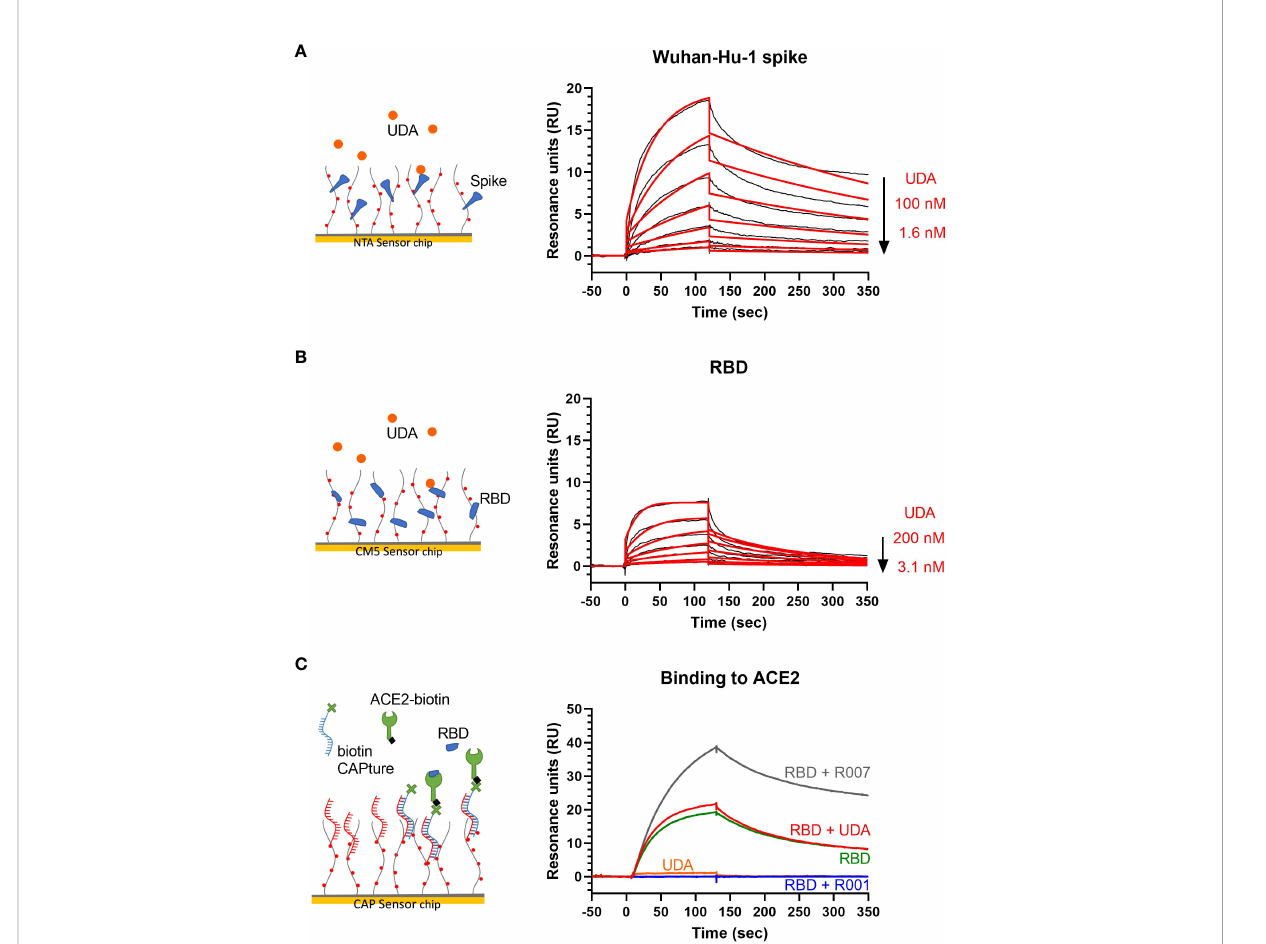
FIGURE 4 Surface plasmon resonance (SPR) analysis of UDA. (A) SPR sensorgram showing the binding kinetics for UDA and immobilized monomeric Wuhan-Hu-1 spike protein (1:2 dilutions of UDA, starting from 100 nM). Data are shown as black lines, and the best fi t of the data to a 1:1 binding model is shown in red. (B) SPR sensorgram showing the binding kinetics for UDA and immobilized RBD of Wuhan-Hu-1 spike protein (1:2 dilutions of UDA, starting from 200 nM), with a fast off rate. Data are shown as black lines, and the best fi t of the data to a 1:1 binding model is shown in red. (C) Biotinylated ACE2 was coupled as ligand to a CAP sensor chip. Graph shows sensorgrams for the binding of different analytes to ACE2. Green curve: RBD (50 nM) only; red curve: RBD (50 nM) + UDA (1 µM); grey curve: RBD (50 nM) + non-neutralising spike- binding antibody R007 (50 nM); blue curve: RBD (50 nM) + spike-neutralising antibody R001 (50 nM); orange curve: UDA (1 µM) only. Note that RBD in complex with R007 can still bind to ACE2 resulting in a stronger resonance signal induced by the large protein complex. See Supplementary Figure 4A for kinetics